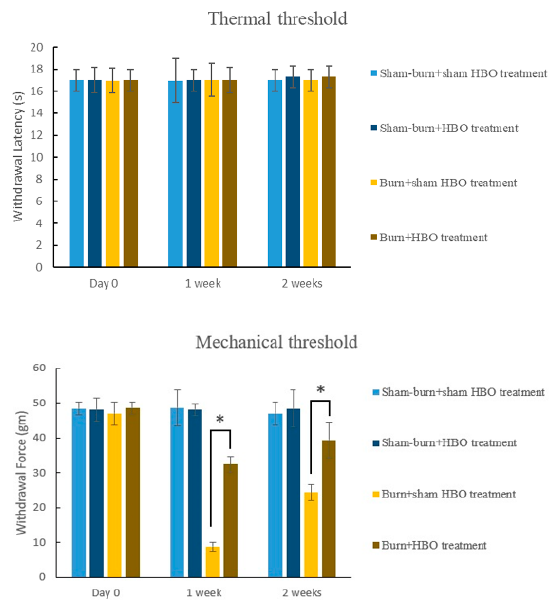
Figure 1. Mechanical withdrawal threshold (MWT) and thermal withdrawal latency (TWL) in each group (n = 6 rats per group). No change in thermal hyperalgesia was observed between groups. The MWT increased significantly in the burn with hyperbaric oxygenation (HBO) treatment group compared with the burn with sham HBO treatment group. * p < 0.05; third-degree burn injury.